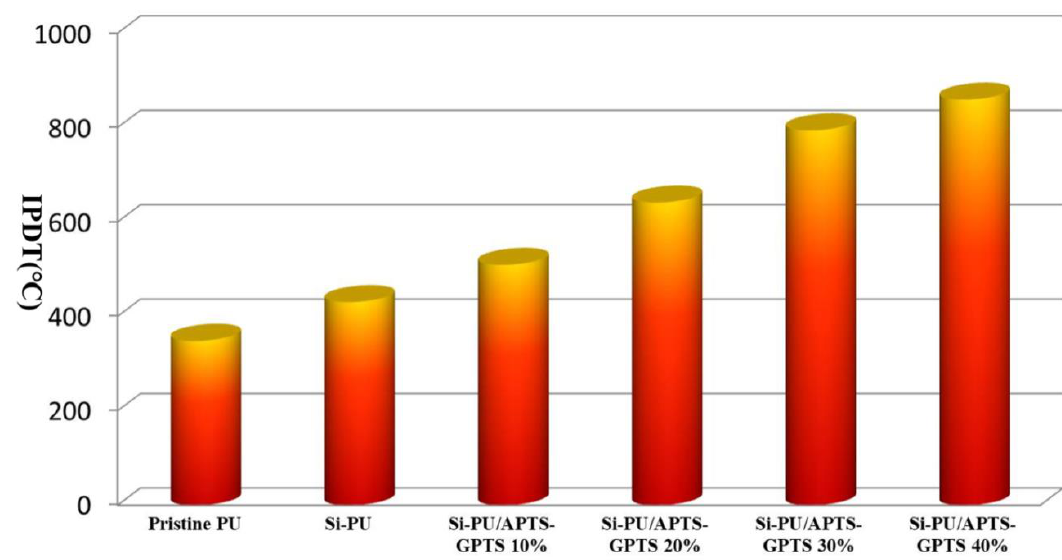
Figure 9. The IPDT data of pristine PU and Si-PU / APTS-GPTS